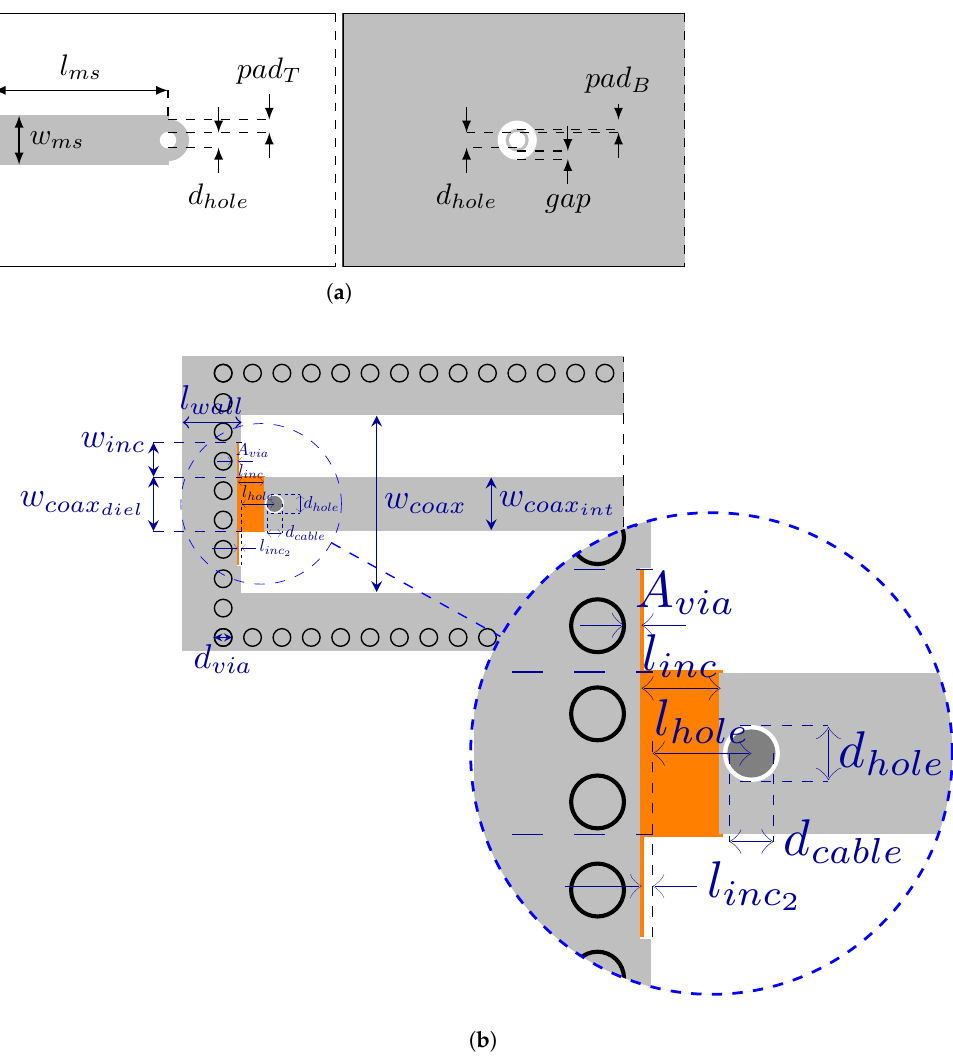
Figure 2. Detailed layout of the transition: ( a ) Upper ( right ) and bottom ( left ) views of the top cover; ( b ) upper view of the central layer and detail (orange color represents non-metallized